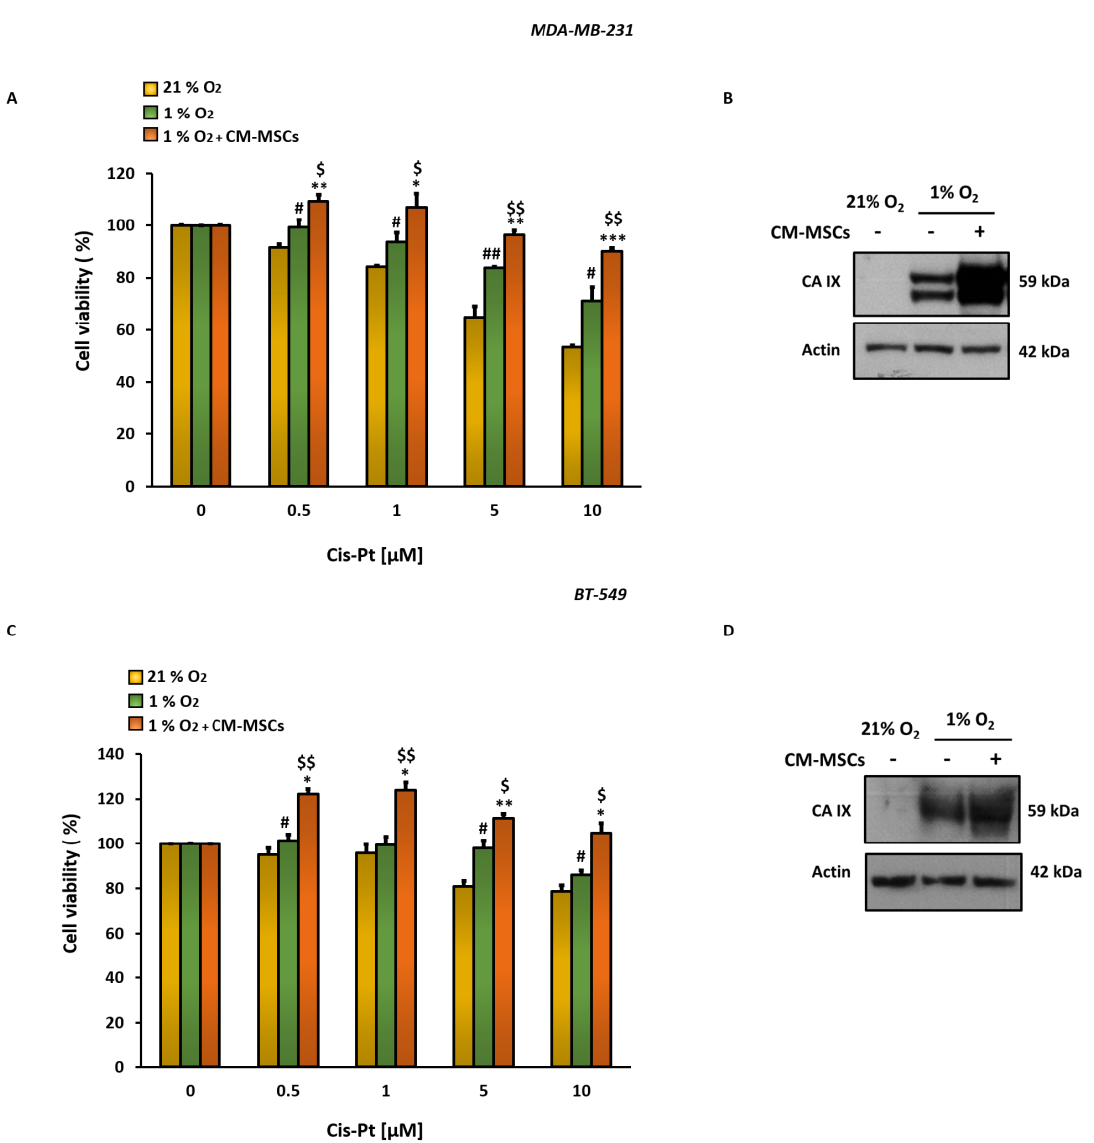
Figure 1. CM-MSCs in hypoxic TME increase Cis-Pt insensitivity in TNBC cells. MTS assay of MDA- MB-231 ( A ) and BT-549 ( C ) cells, grown under normoxic (21% O 2 ) and hypoxic (1% O 2 ) conditions in the presence or absence of CM-MSCs for 72 h and treated with different concentrations of Cis-Pt (from 0.5 µ M to 10 µ M). All the data are expressed as percentages of viable cells, considering the untreated control cells as 100%. Bars depict mean ± SD of three independent experiments (1% O 2 vs. 21% O 2 : ## p < 0.001, # p < 0.01; 1% O 2 + CM-MSCs vs. 21% O 2 : *** p < 0.0001, ** p < 0.001, * p < 0.01; 1% O 2 + CM-MSCs vs. 1% O 2 : $$ p < 0.001, $ p < 0.01). ( B – D ) CA IX protein levels were analyzed using Western blot analysis under the same conditions described above, and actin was used as a loading